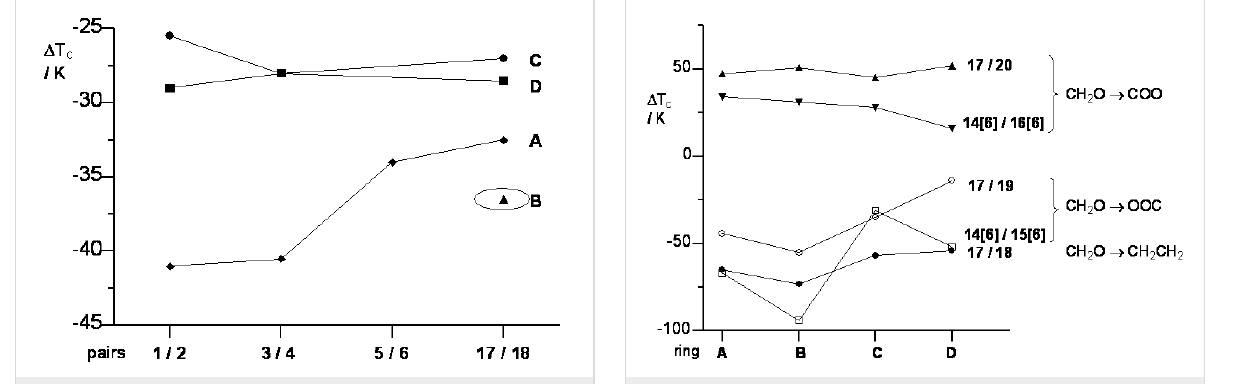
Figure 6: The change in the clearing temperature Δ T c upon replacing of the –OCH 2 – connecting group with another in selected pairs of com- pounds. The lines are guides for the